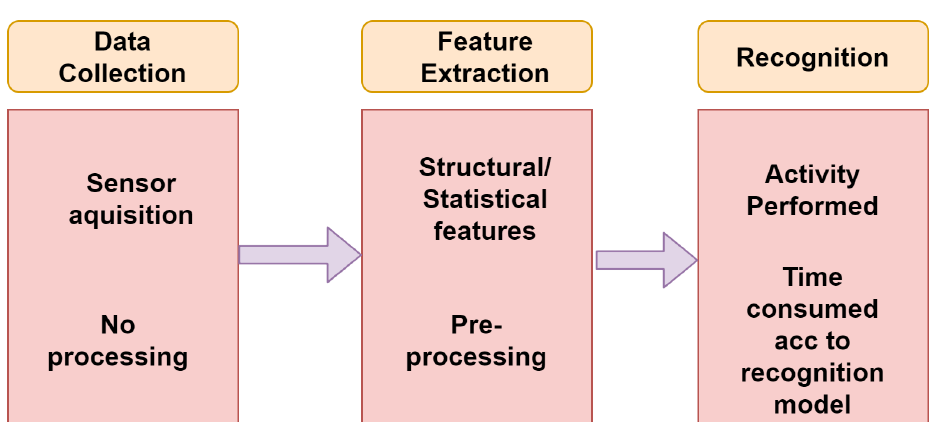
Figure 1. Learning phase of HAR.